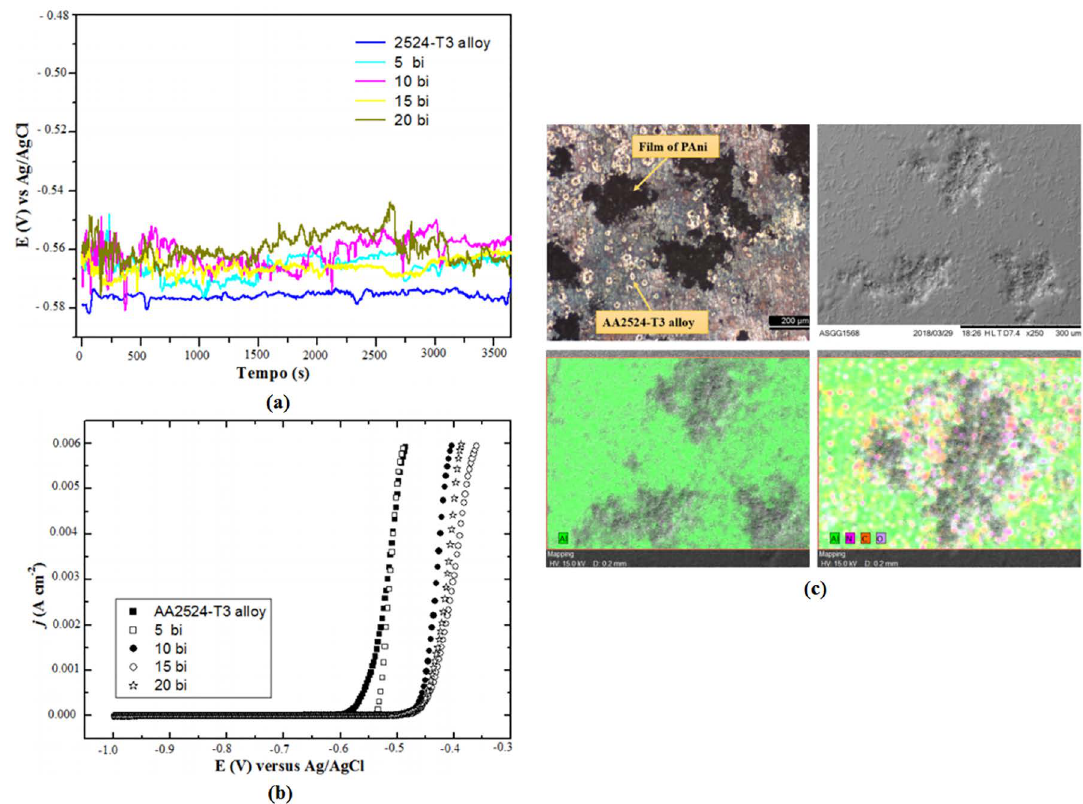
Figure 5. (a) OCP curves for the AA2524-T3 alloy in aerated 0.6 mol L -1 aqueous solution for a period of 3600 s of immersion, (b) PPc for the AA2524-T3 alloy in aerated 0.6 mol L -1 NaCl aqueous solution at scan rate of 0.5 mV s -1 , (c) images of surface alloy by optical microscopy and SEM in the pitting potential (E ) for a 15 bilayer PAni-NPs/PSS film. EDX analysis confirms the presence of PAni-NPs/ pit PSS films on the surface of the AA2524-T3